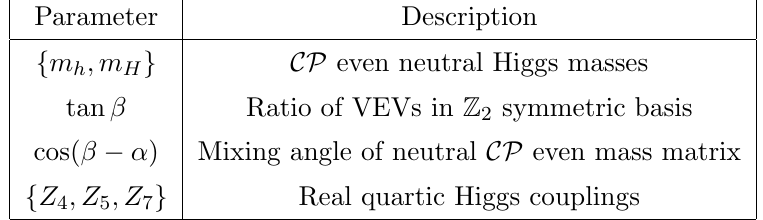
Table 2 . Hybrid basis for a softly broken Z 2 symmetric CP -invariant 2HDM from ref. [35]. Imposing an exact Z 2 symmetry (cid:12)xes Z 7 according to eq. (2.28), with (cid:22) m 2 =